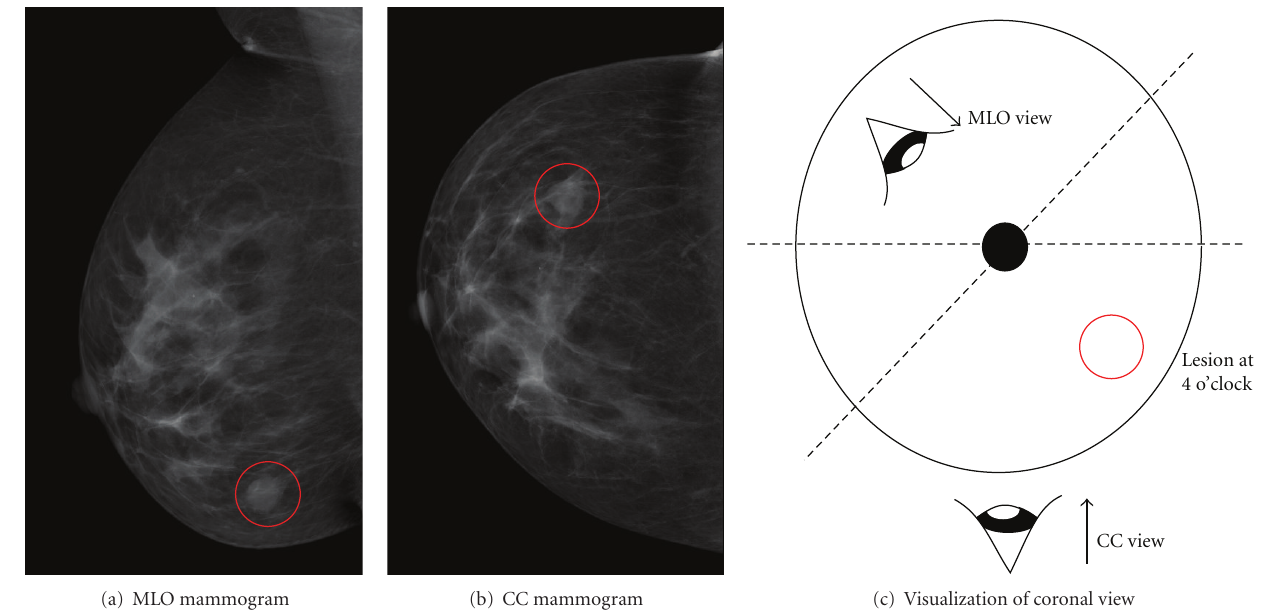
Figure 1: O’clock position of a lesion on a right breast as identified by radiology report.